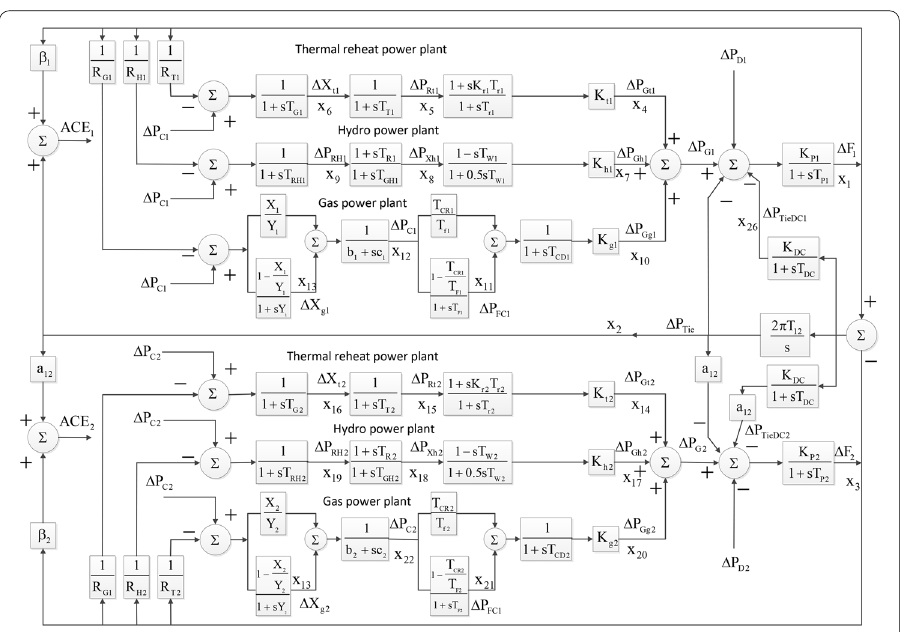
Fig. 1 Two-area multi-source power system (Test system-I)